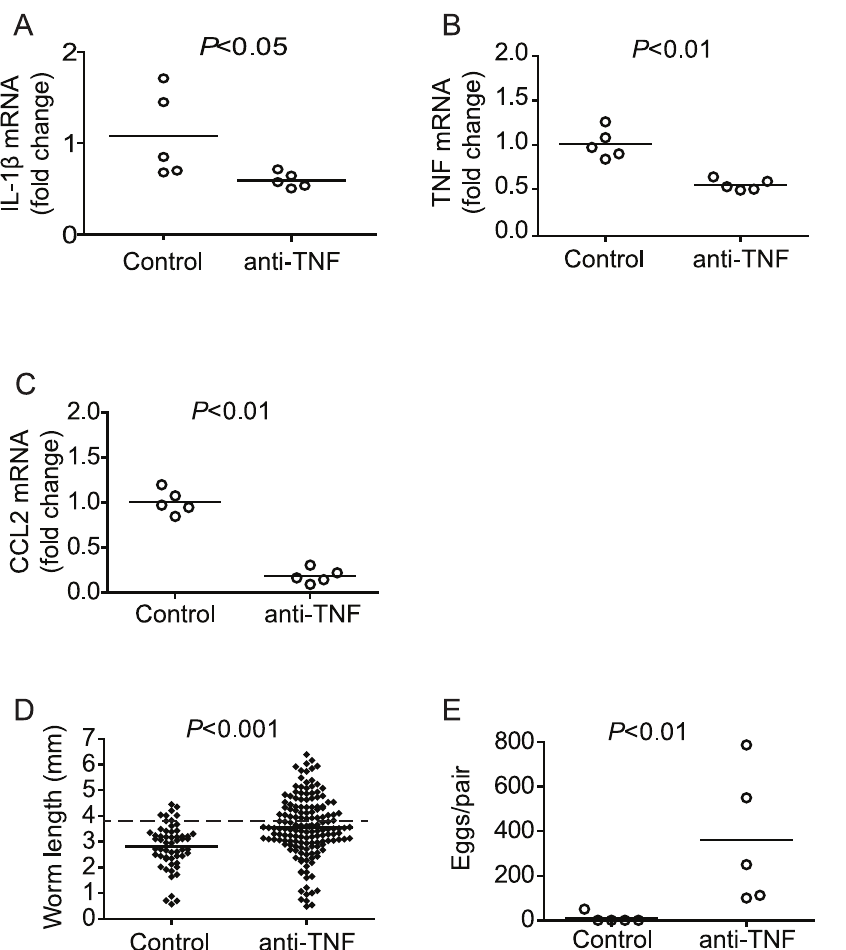
Figure 6. Chronic administration of anti-TNF antibody restores regulation of pro-inflammatory cytokine transcription and parasite development in infected RAG 2 / 2 mice. Groups of S. mansoni -infected RAG 2 / 2 mice were repeatedly treated throughout pre-patent infection with anti-TNF antibody, as described in Materials and Methods. At 6 weeks p.i., mice were euthanized, parasites perfused from the portal tract and spleens removed for analysis of IL-1 b (A), TNF (B) and CCL2 (C) mRNA content by real-time PCR. (D) Length of male worms and (E) liver egg burdens from RAG 2 / 2 mice treated with anti-TNF antibody. Horizontal bars represent mean values for each experimental group. P values were calculated using the Mann Whitney test and student’s T-test with Welch’s correction. Dashed line in D indicates the average length of male S. mansoni worms recovered from wild type mice at day 42 post infection (3.9 mm).